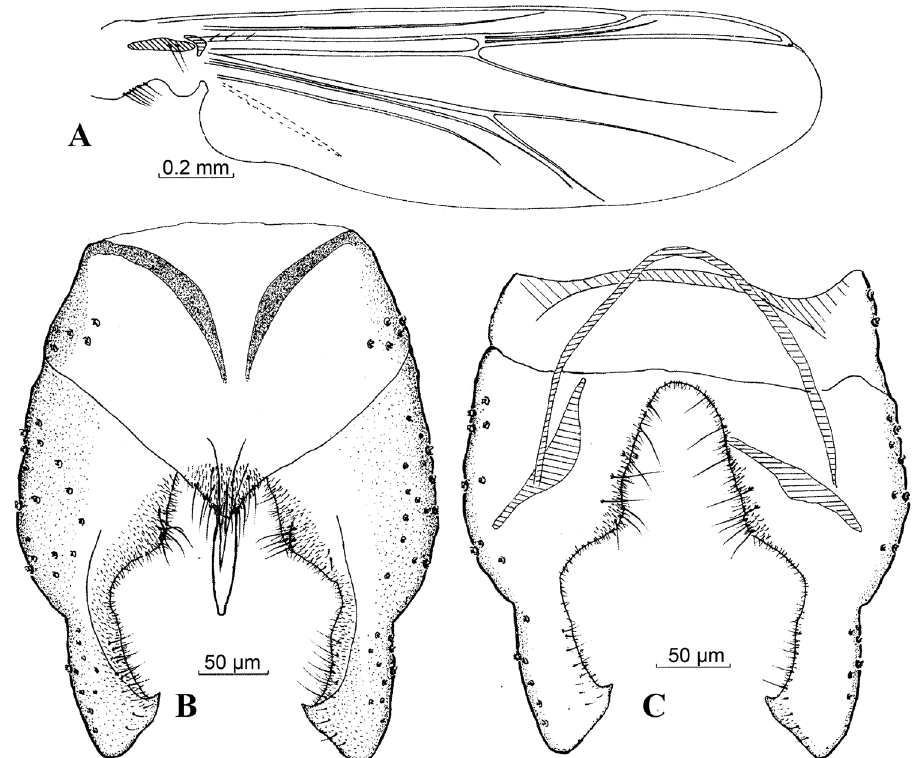
Figure 1. Harnischia angularis . A Wing; Hypopygium: B (dorsal) C